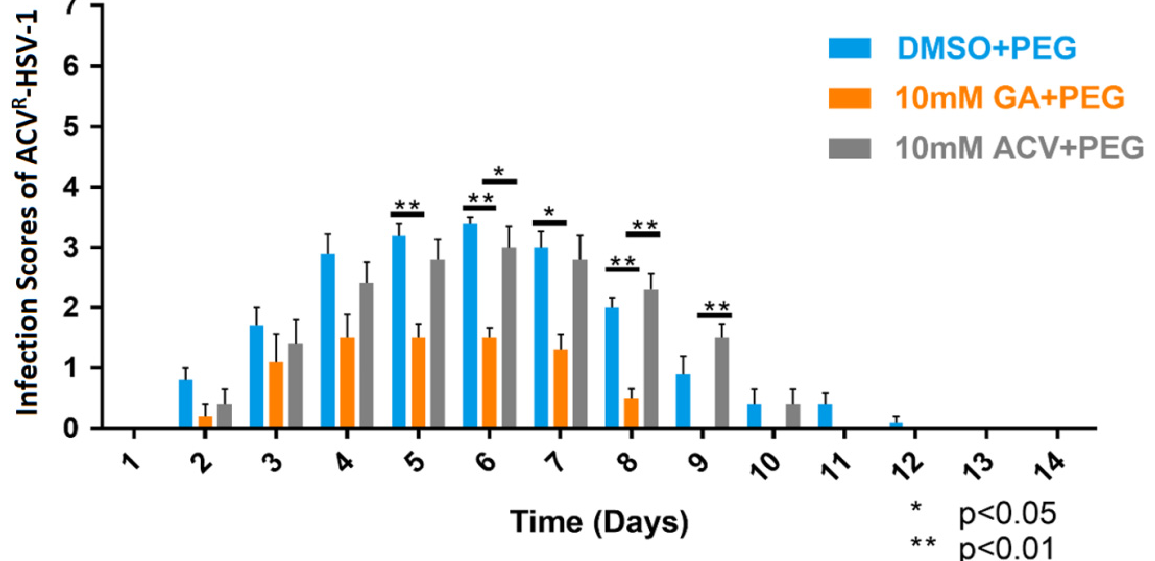
Figure 4. ACV R -HSV-1 average zosteriform infection scores of BALB/cJ mice, following the application of 10% DMSO in polyethylene glycol (PEG), 10 mM GA in PEG, and 10 mM ACV in PEG (N = 5/group). Age-matched BALB/cJ mice were inoculated with 2.0 × 10 5 PFU of ACV R -HSV-1 using the epidermal scarification-zosteriform model. Each group received the respective treatments and were monitored for 14 days. The infection scores of surviving animals were averaged in each treatment group for each day. GA-treated animals demonstrated a significant reduction in the appearance of vesicles and erosions compared to vehicle-treated control animals. Student independent t -tests (2-tailed); * p < 0.05; ** p < 0.01. All error bars represent SEM.